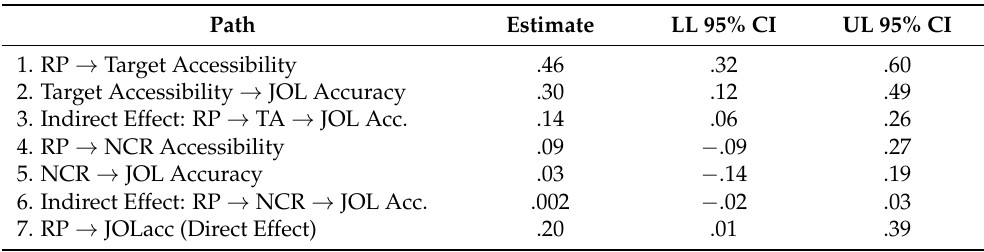
Table 11. Stage-2 Meta-analytic mediation model of study technique and JOL accuracy (related